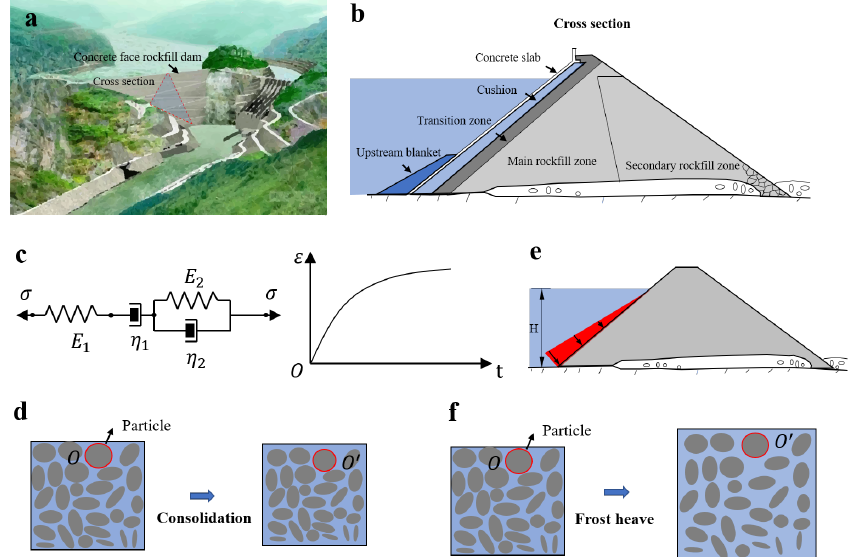
Figure 1. Schematic diagram of the CFRD and the main components of the settlements: ( a ) sketch of the CFRD, ( b ) structure of the main body of the CFRD, ( c ) creep deformation component, ( d ) consoli- dation of soil particles, ( e ) hydrostatic load component, ( f ) frost heave of soil particles. In the process of the secondary consolidation of the soil, effective stress on the soil particles remains almost unchanged, but the volume of the soil still grows with